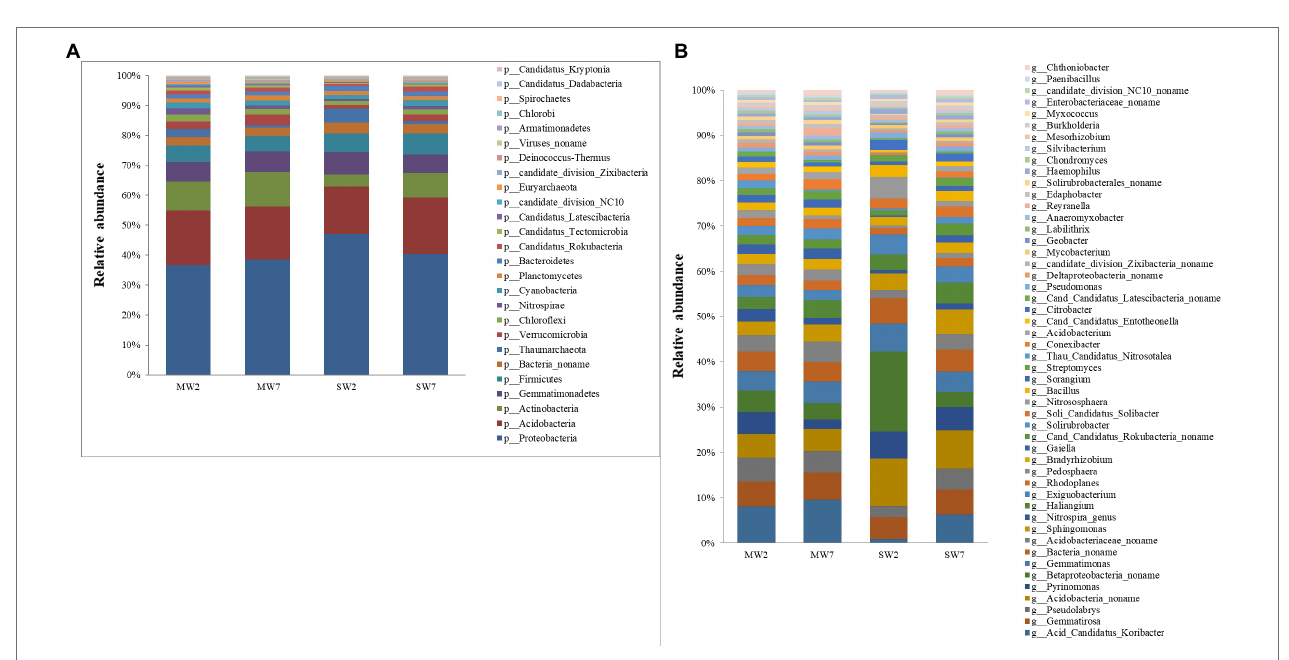
FIGURE 2 | Relative abundances of soil microbial community in rotation treatments. MW2, maize-wheat rotations for 2 years; MW7, maize-wheat rotations for 7 years; SW2, soybean-wheat rotations for 2 years; SW7, soybean-wheat rotations for 7 years.